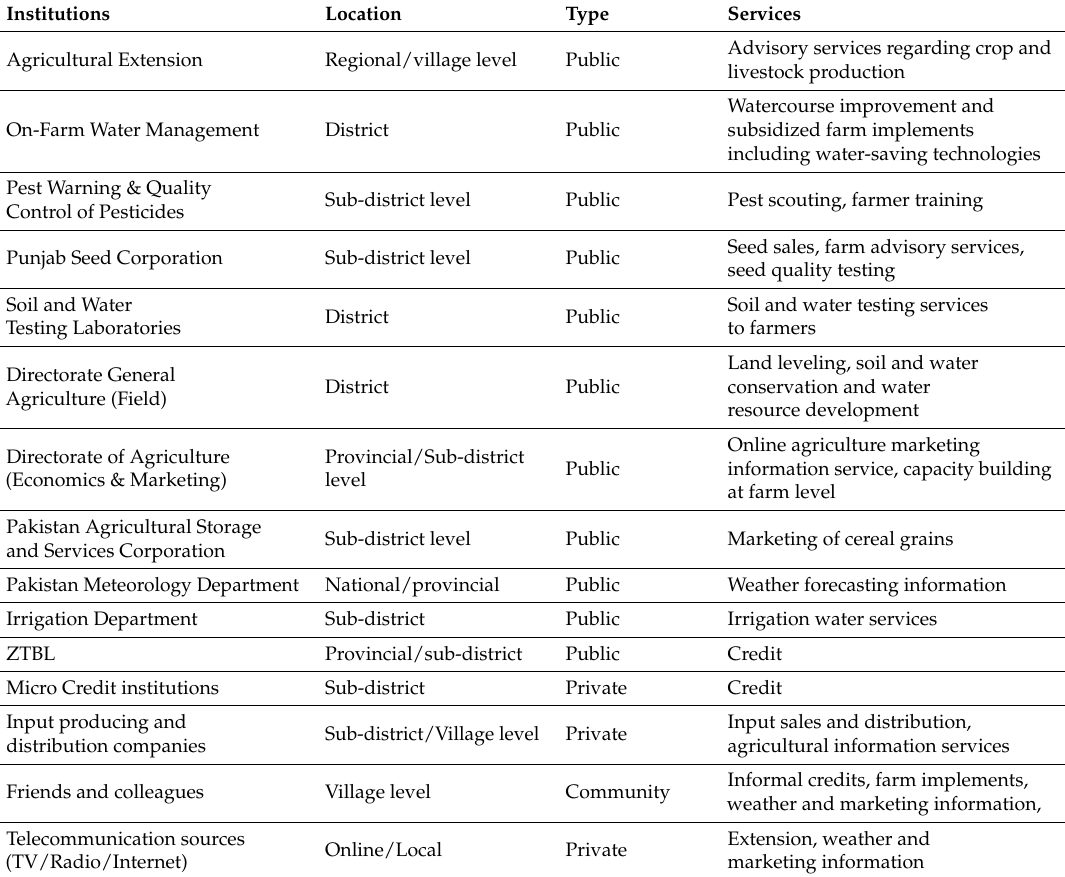
Table 2. Institutions that provide on-farm services to